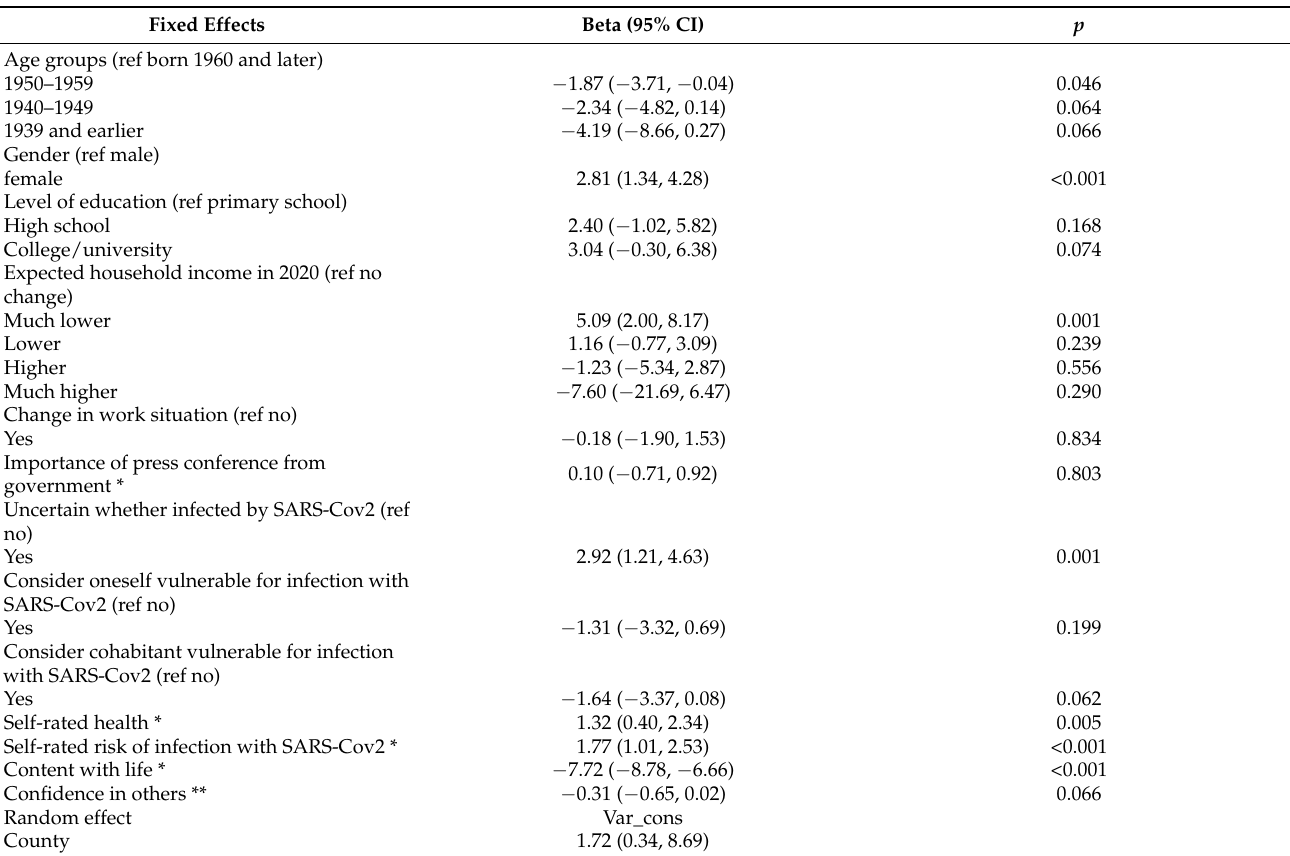
Table 3. Factors associated with level of emotional distress in the COVID-19 wave in March 2020 of the Norwegian Citizen Panel (N: